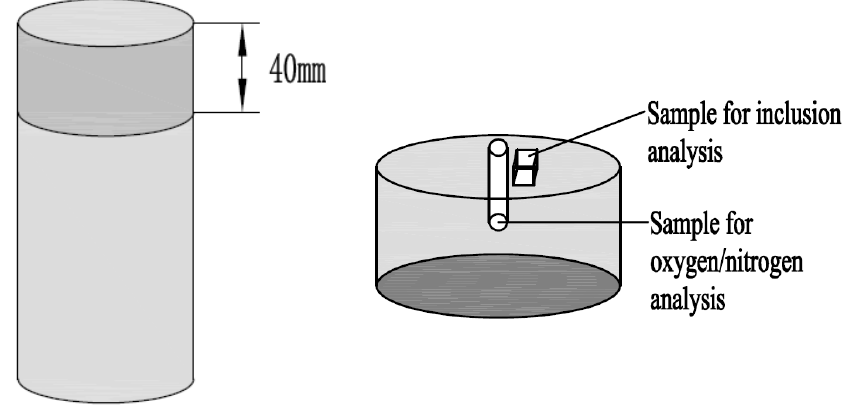
Figure 2. Schematic diagram of